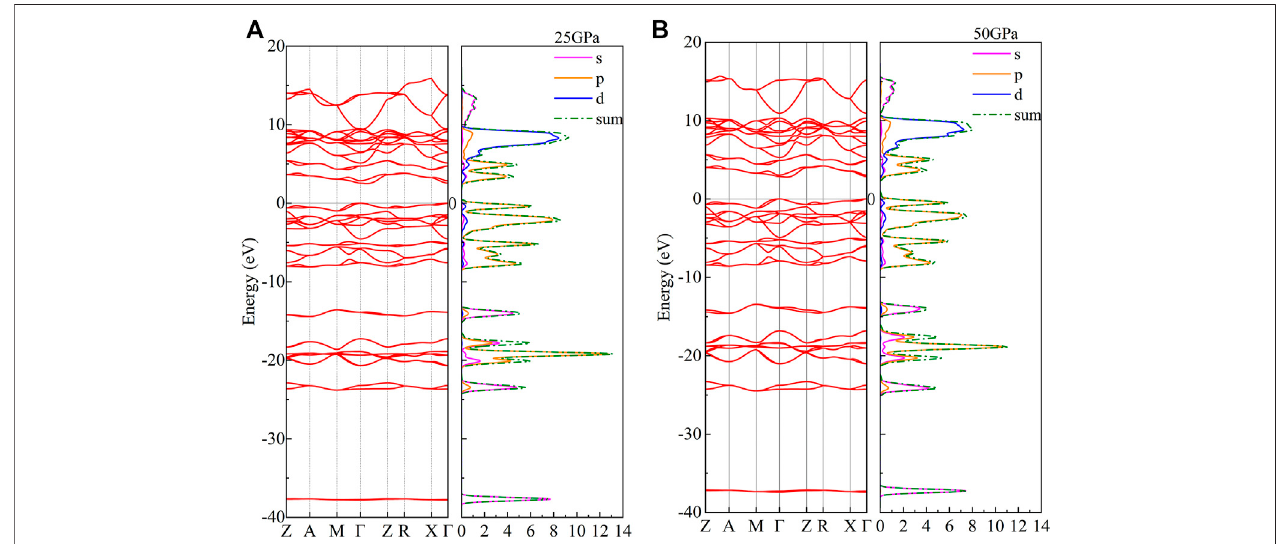
FIGURE 6 | Density of states and band structure ofCaO 3 at (A) 25 GPa and (B) 50 GPa. The red curve represents the band structure; the magenta curve, orange curve, and blue curve represent the DOS of s-orbitals, p-orbitals, and d-orbitals, respectively; and the green dot-dash line represents the total value of the DOS.